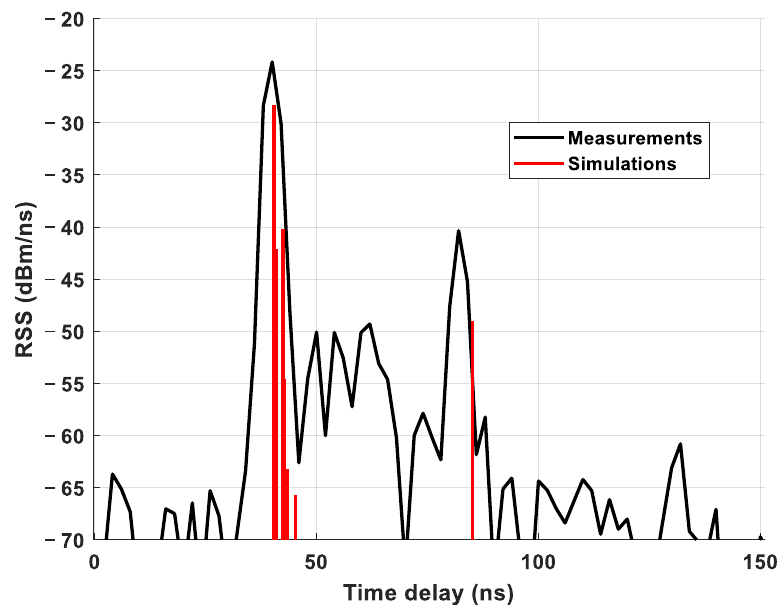
Figure 12. PDP at Rx2_150°.